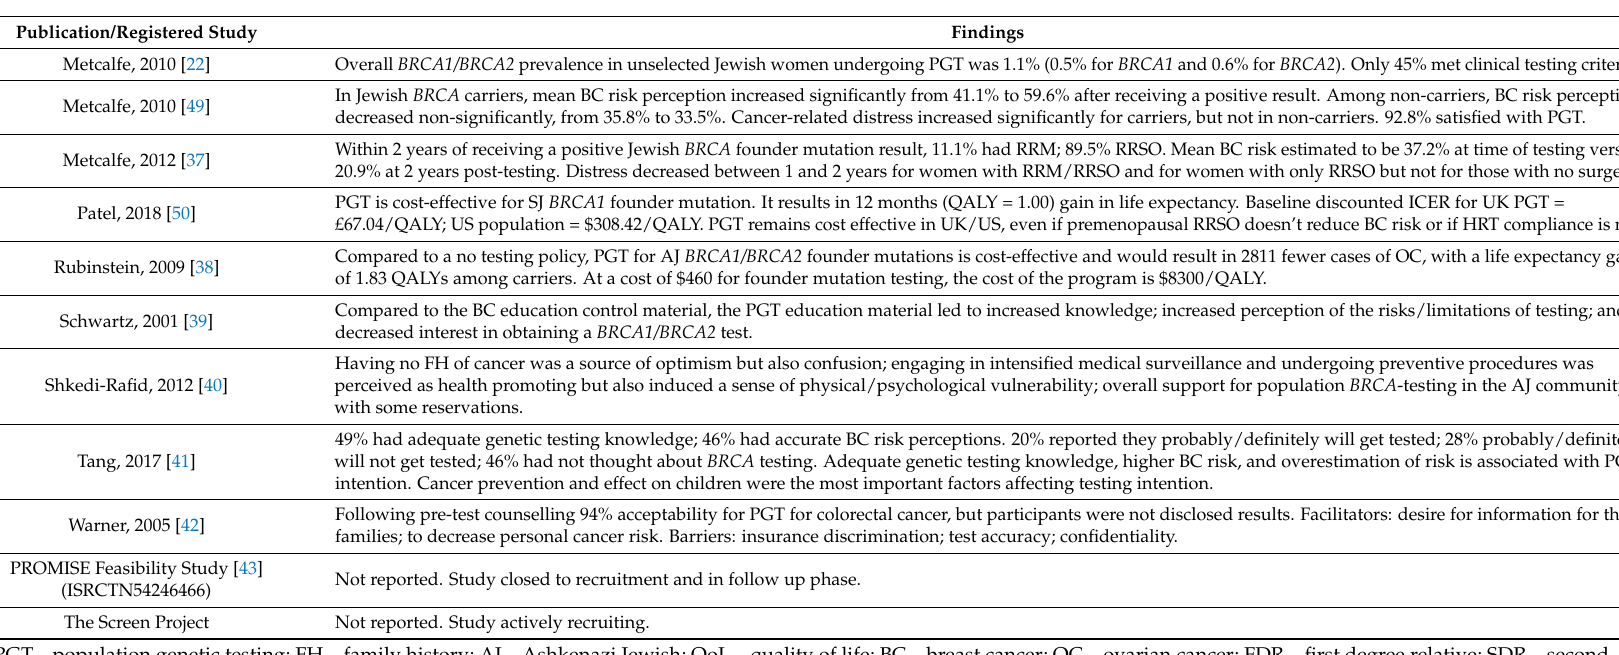
Table 3. Findings of publications and registered studies reporting population genetic testing